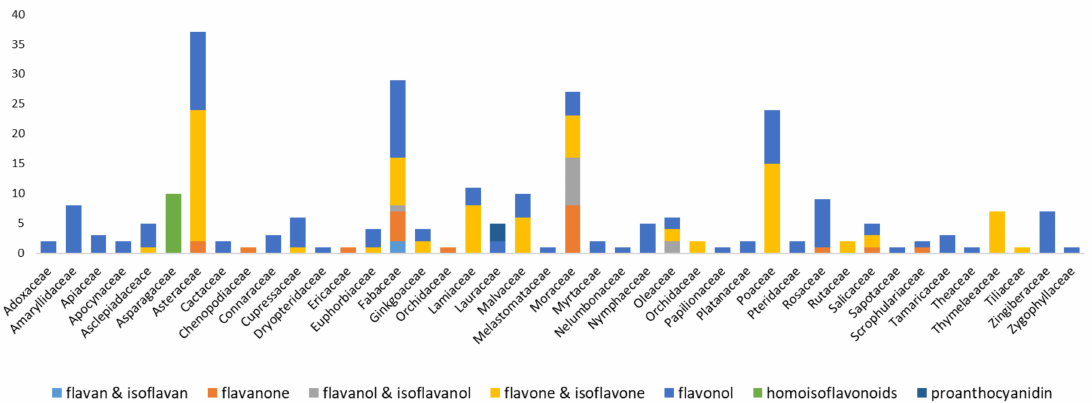
Figure 2. Number of flavonoid derivatives isolated or purified by Sephedex ® LH-20. Overall, 17 di ff erent eluents have been applied to isolate / purify flavonoids through SLH